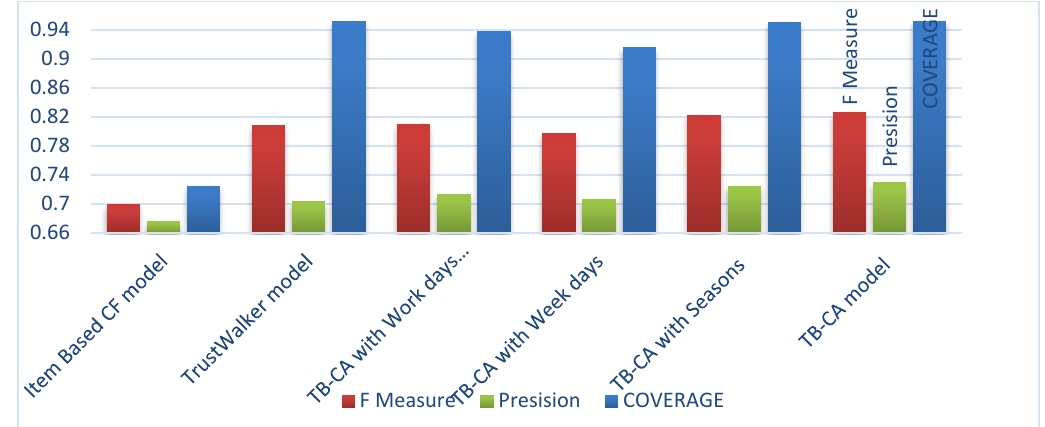
Fig. 3. Precision, coverage and F measure for different models on all